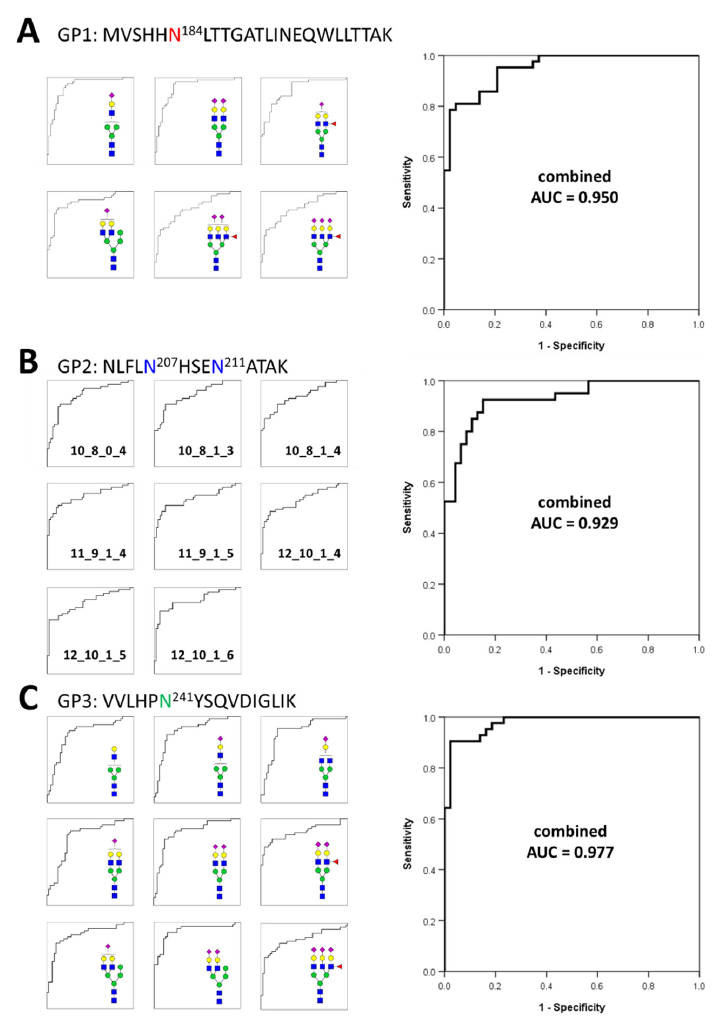
Figure 4. Individual and combined ROC curves using statistically significant glycopeptides. The small ROC curves on the left side are statistically significant individual glycopeptides in each glycopeptide group. On the right is the combined ROC curves derived using statistically significant individual glycopeptides for each glycopeptide group. The ROC curves of individual glycopeptides were calculated using their absolute abundances and combined ROC curves were derived using the logistic regression of glycopeptides. ( A )—6 individual glycopeptides and their combined biomarker from GP1; ( B )—8 individual glycopeptides and their combined biomarker from GP2; ( C )—9 individual glycopeptides and their combined biomarker from GP3. In addition, in order to verify the association between the glycan class of serum haptoglobin glycopeptides and gastric cancer, their expression levels were compared